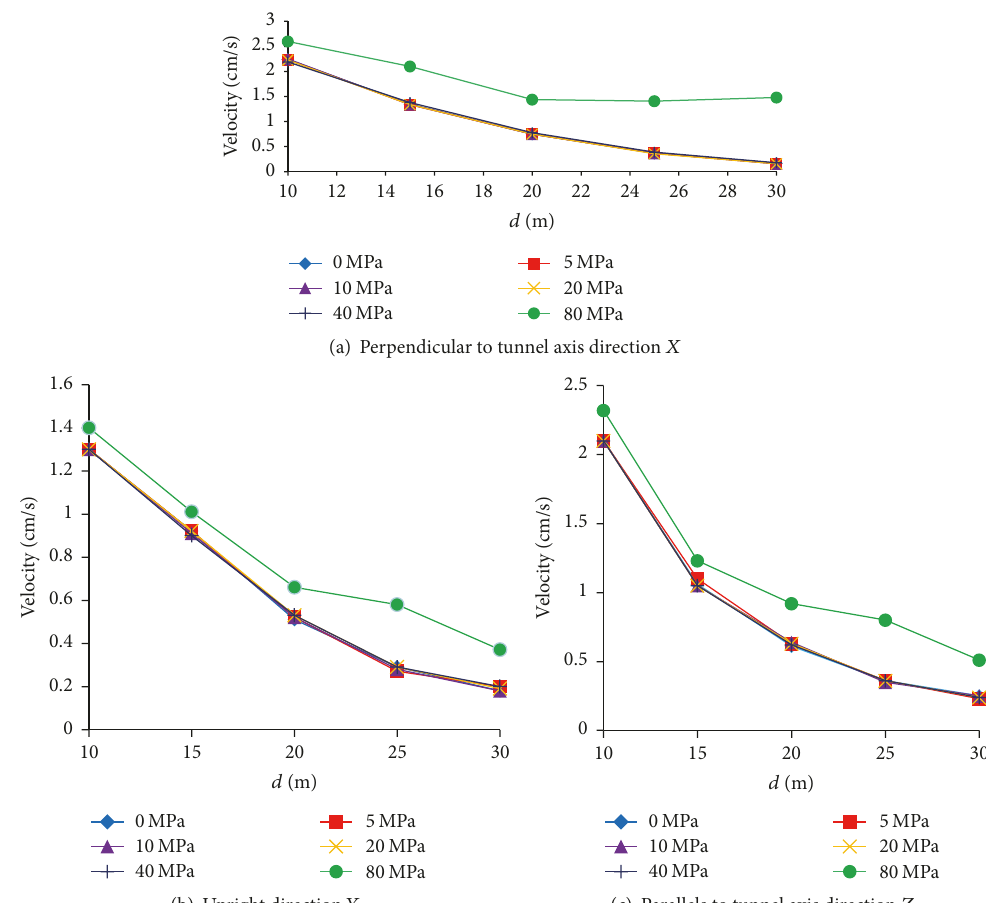
Figure 13: The comparison of vibration velocity in the same measuring point under different crustal